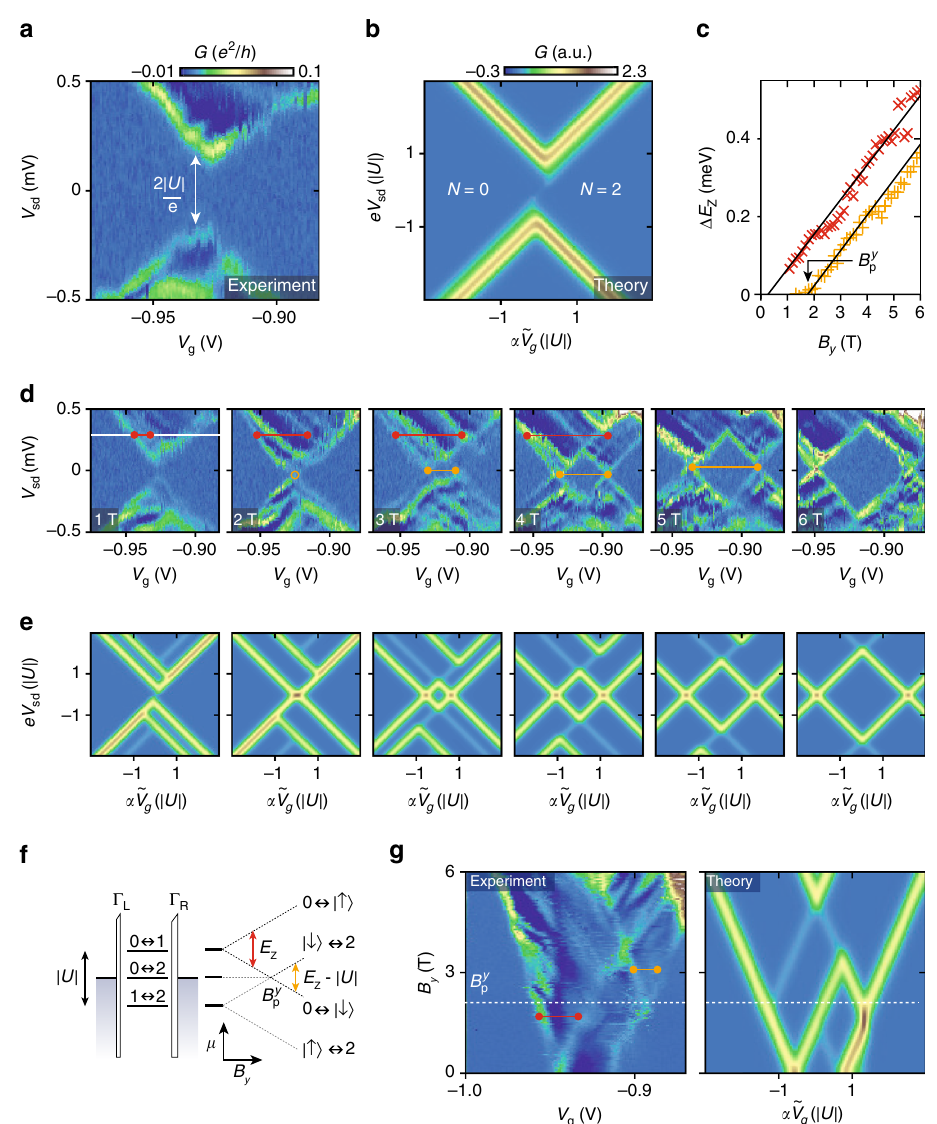
Fig. 2 Excited state spectroscopy. a Bias spectroscopy in the region of a single-pair transition shown in Fig. 1d. The transport gap | U |= 160 μ eV is indicated. b Corresponding transport calculation of the bias spectroscopy based on a single-orbital Anderson model with attractive interactions and occupation N . c Zeeman energy splitting Δ E Z extracted from measurements in d , g . The energies for the ground (excited) state transitions are indicated by orange ( red ) ¼ 1 : 8 T . d Evolution of the bias spectroscopy measurements with magnetic fi eld B markers. The linear fi ts yields | g |= 1.5 and intercept B y p calculations shown in e . The color scales for d , e are as in a , b , respectively. f Schematic illustration of the electrochemical potentials for the relevant transitions in the QD and their evolution with magnetic fi eld. For the splitting of the ground state, Δ E Z = E Z − | U | ( orange line ), and for the splitting of the excited state ( red line ) Δ E = E = g μ Z Z , where E Z B B y is the Zeeman energy. The associated features are indicated in the bias spectra ( d , g ) by orange / red lines. g Measured and simulated magnetic fi eld dependence of G ( V g ) at V sd = 300 μ eV ( white line in b ), highlighting the magnetic fi eld dependence of the excited state